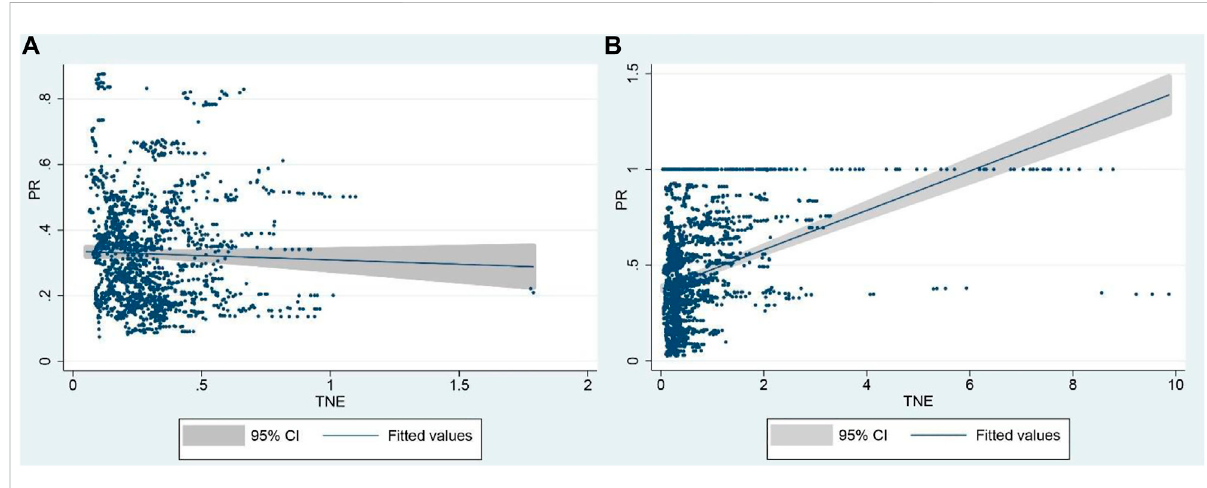
FIGURE 7 The difference in the correlation between the spatial structure and the scale of employees in RBCs and non-RBCs. (A) RBCs; (B) non-RBCs.